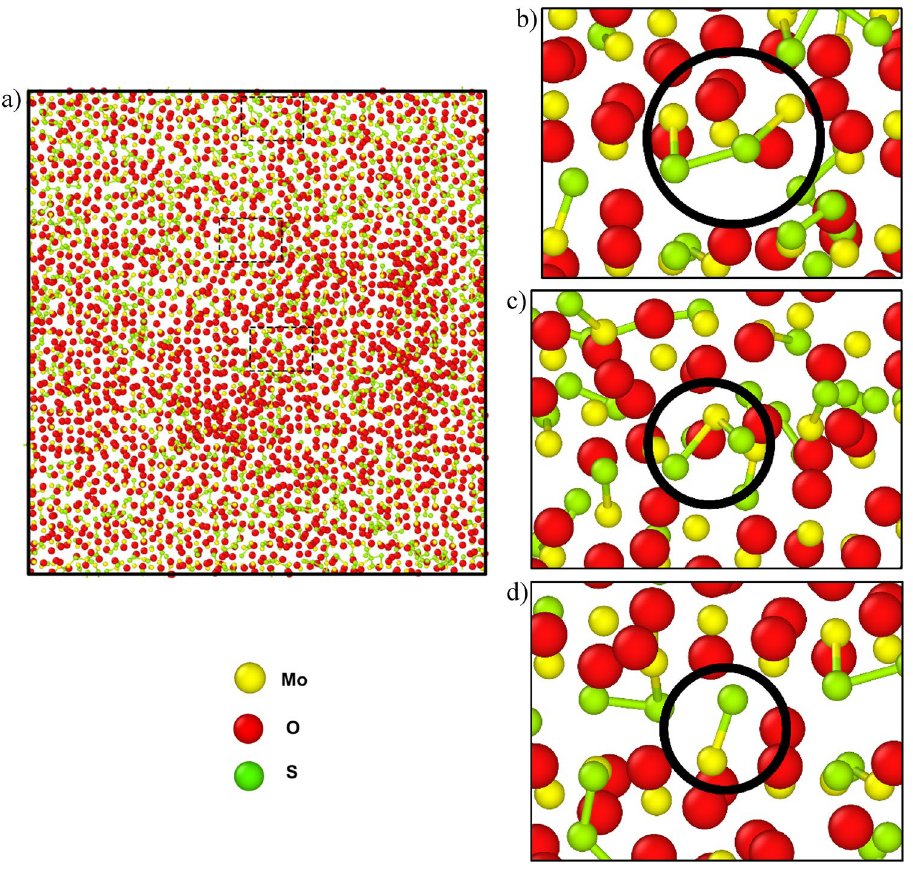
Figure 10. The surface composition due to the S 2 precursor at 375 ps. ( a ) The formation of the MoO 2.01 S 1.27 surface showing the enlarged regions highlighting the ( b ) Mo-S 2 -Mo, ( c ) MoS 2 , and ( d ) MoS